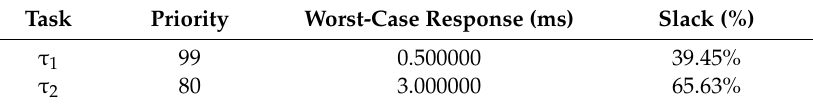
Table 2. Calculation of the worst-case response time using MAST [36].